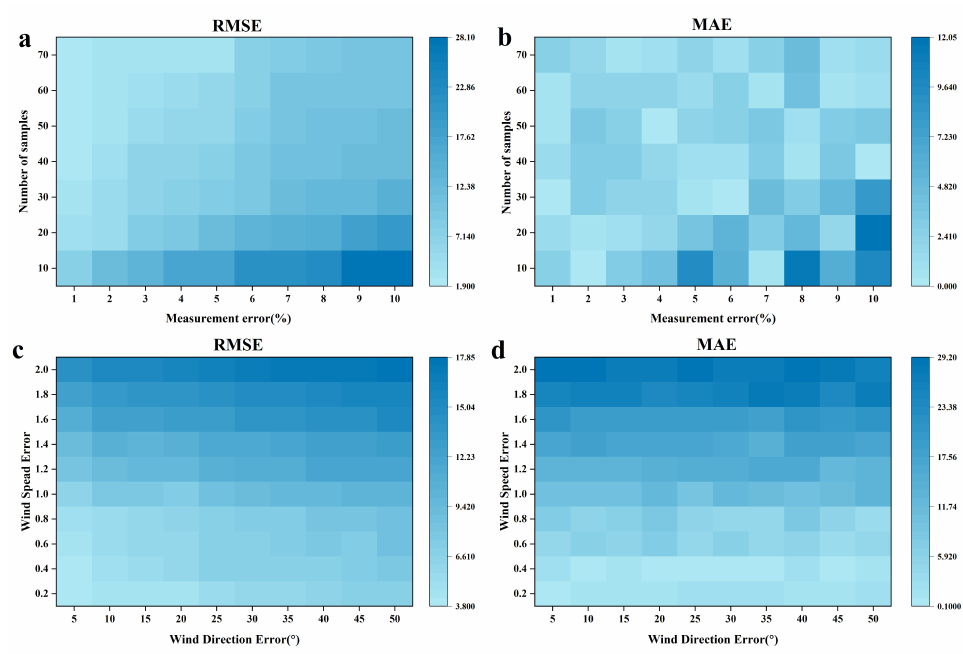
Figure 4. Effect of joint error on retrieval accuracy. ( a , b ) RMSE and MAE for optimal estimation of CO 2 emissions under the combined effect of measurement error and measurement number, respectively, with measurement error from 1% to 10% and measurement number from 10 to 70. ( c , d ) RMSE and MAE for optimal estimation of CO 2 emissions under the combined effect of wind direction error and wind speed error, respectively, with wind direction error from 5 degrees to 50 degrees and wind speed error from 0.2 m/s to 2